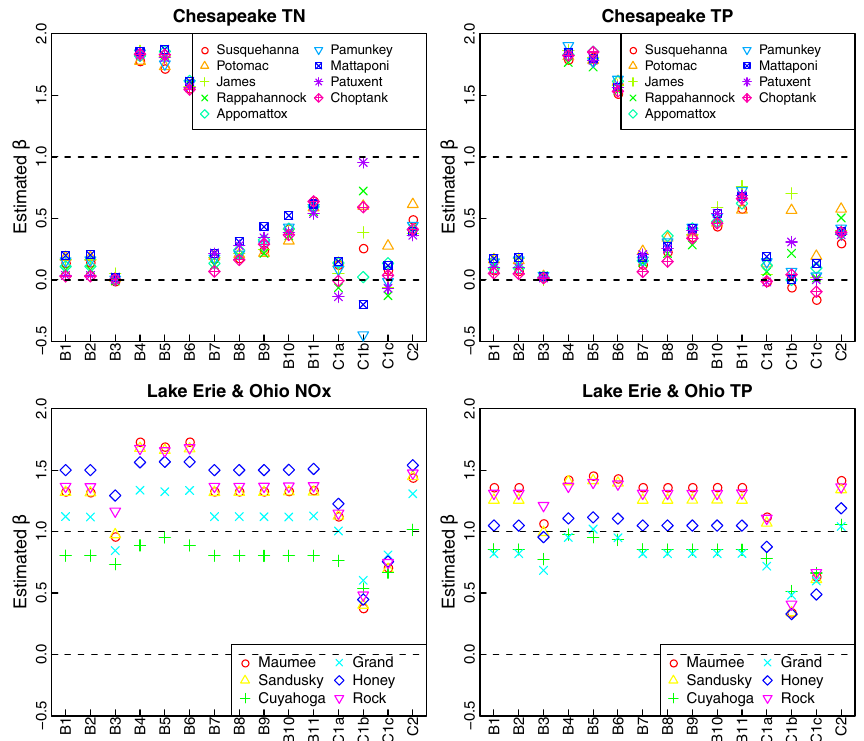
Figure 10. Quantification of spectral slope in real water-quality data from the two regional monitoring networks, as estimated using the set of examined methods. All estimations were performed on concentration residuals (in natural log concentration units) after accounting for effects of time, discharge, and season. The two dashed lines in each panel indicate white noise ( β = 0) and pink (flicker) noise ( β = 1), respectively. See Table 1 for site and data